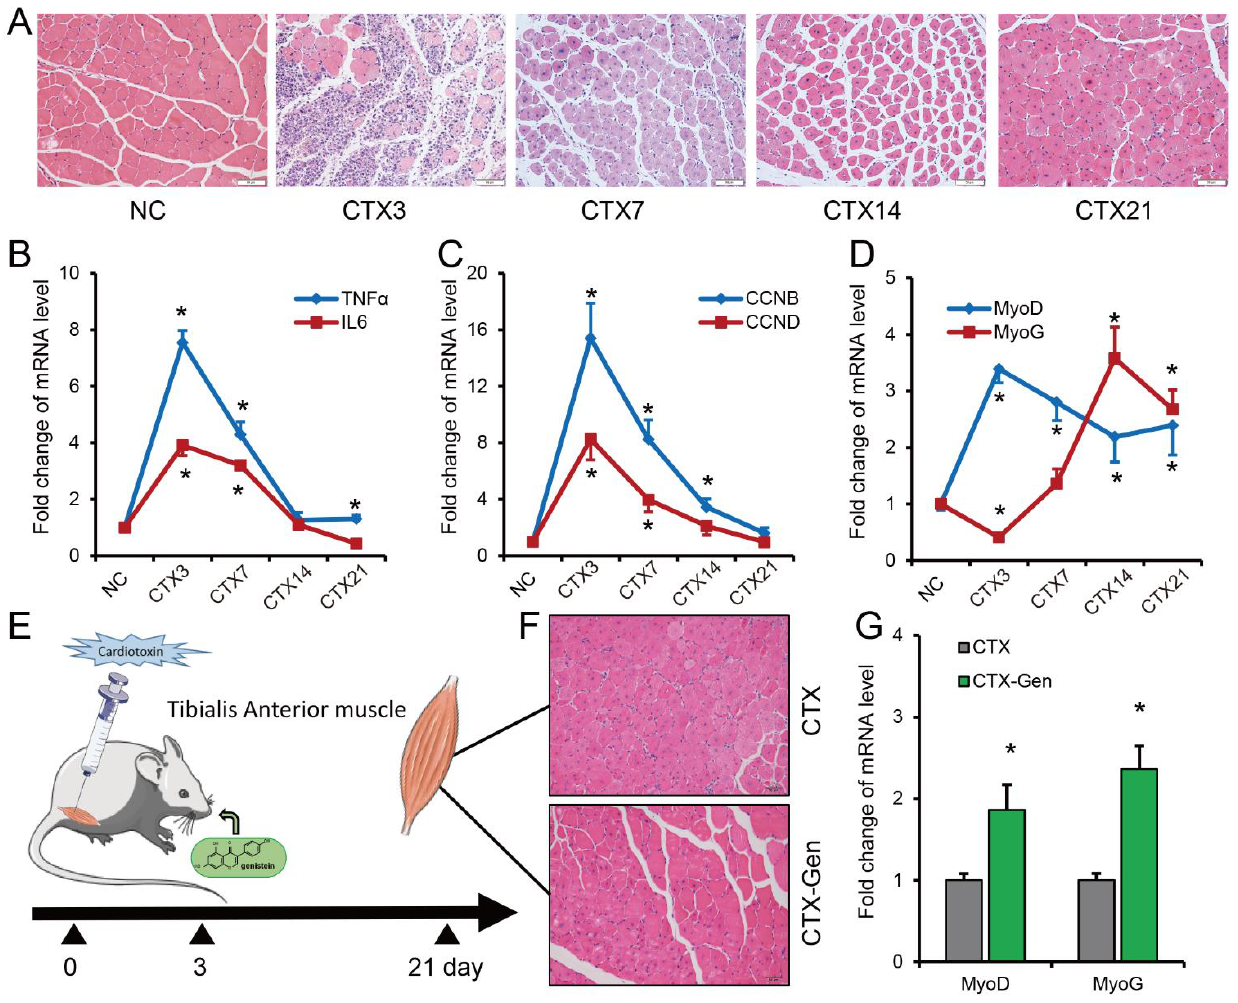
Figure 1. GEN promotes damaged-muscle repair. ( A ) Tibialis anterior (TA) muscle tissue sections of mice on day 0 (NC), day 3 (CTX3), day 7 (CTX7), day 14 (CTX14), and day 21 (CTX21) after cardiotoxin (CTX) injection. ( B ) The expression of TNFα and IL6 in damaged muscle. ( C ) The expression of CCNB and CCND in damaged muscle. ( D ) The expression of MyoD and MyoG in damaged muscle. ( E ) A schematic showing skeletal muscle injury time, injury site, and GEN treatment time in mice. ( F ) Histological sections of TA muscle from GEN-treated (CTX-Gen) and no GEN-treated mice (CTX) 21 days after injury. ( G ) Expression of MyoD and MyoG in TA muscle of no GEN-treated and GEN-treated mice at 21 days of injury. n = 3. * p < 0.05. Scale ruler: 50 µ